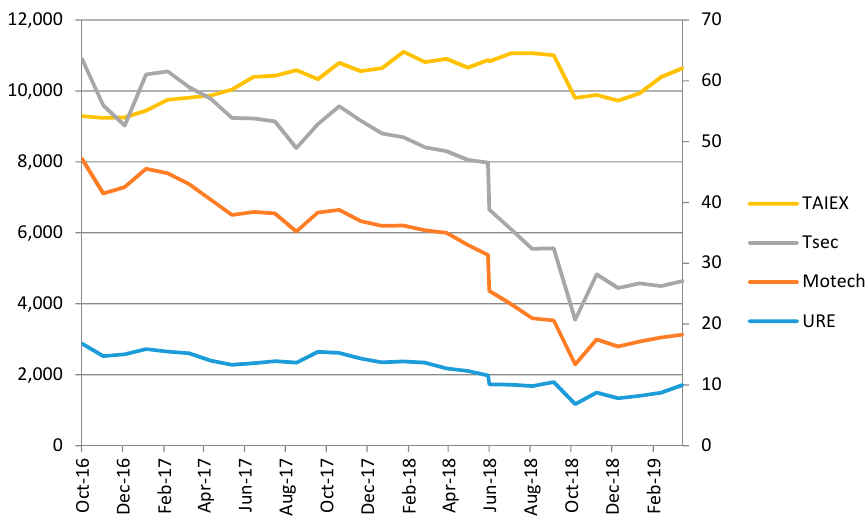
Figure 7. The stock valuation of TSEC, Motech, URE (NTD), and TAIEX index (points) (Sourced: based on Taiwanese Stock Exchange database).